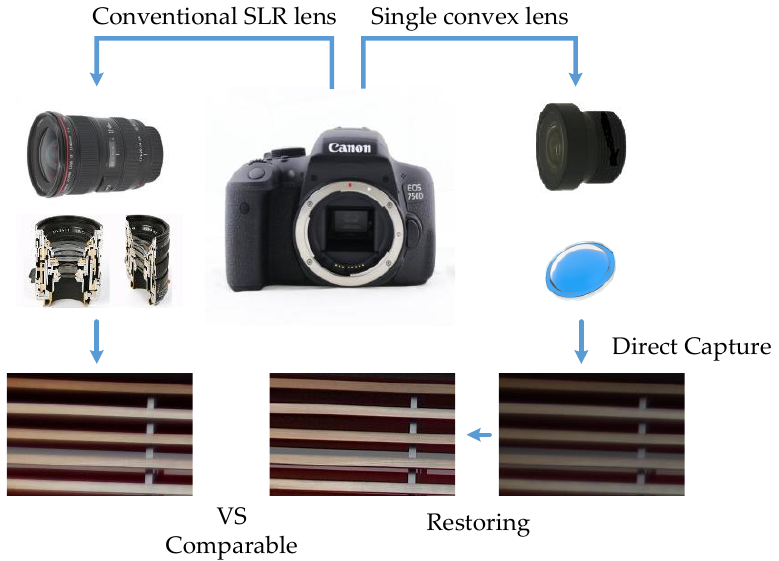
Figure 1. The schematic diagram of single-convex-lens computational imaging method.